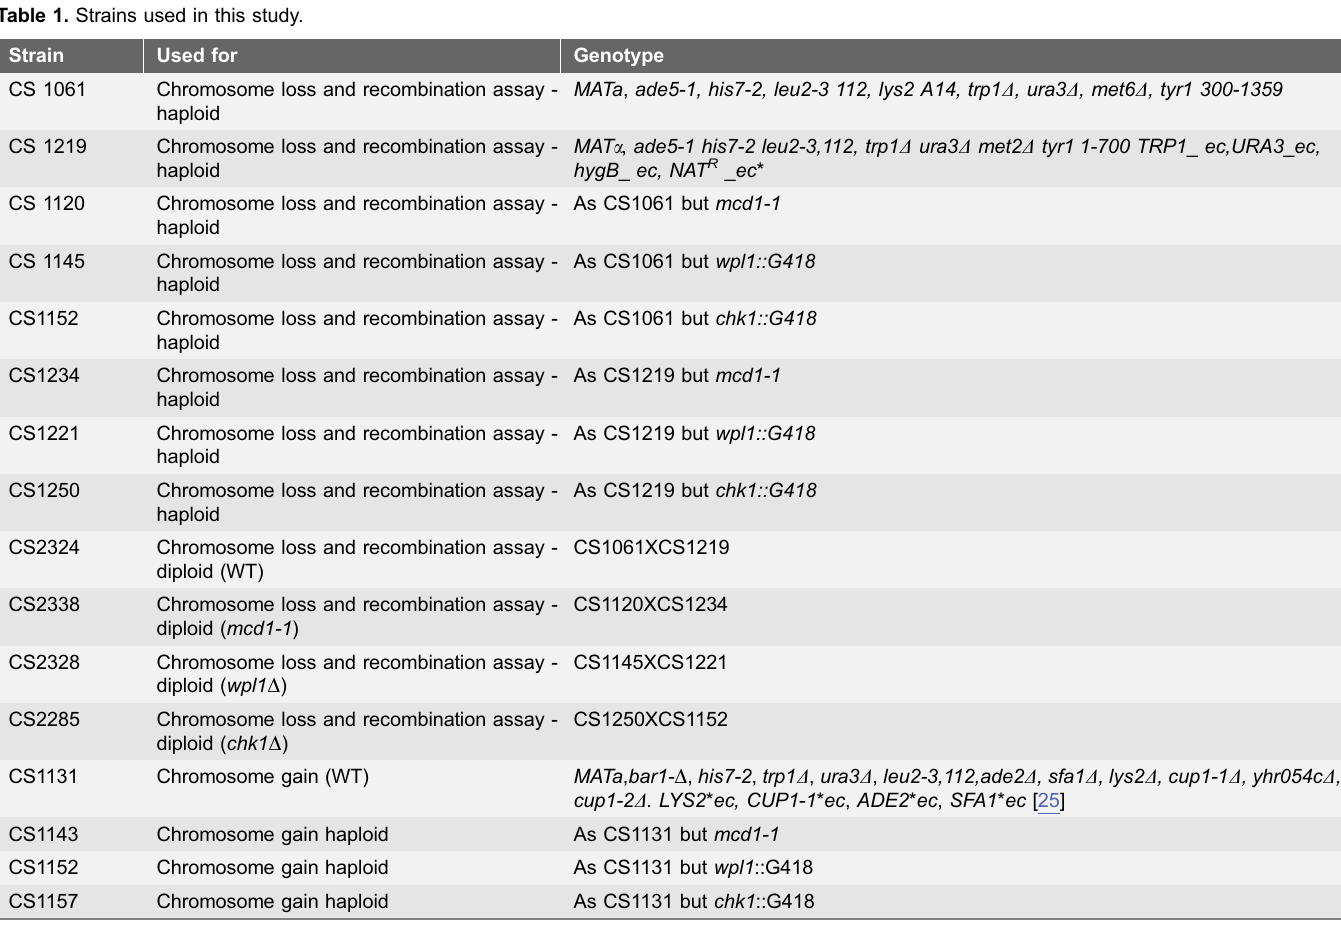
Table 1. Strains used in this